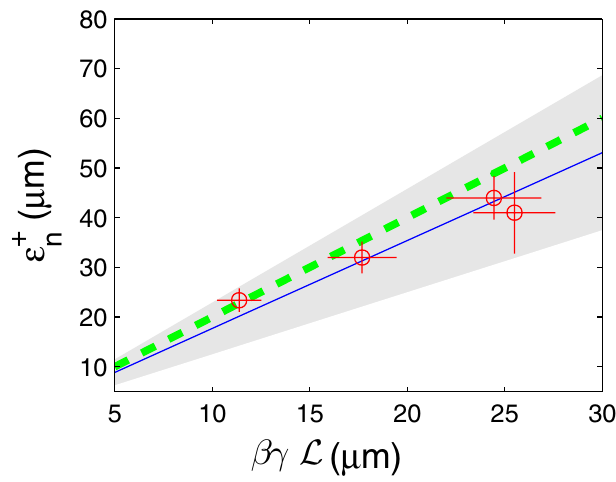
FIG. 7. (Color) Larger one of the flat-beam emittances ( " (cid:4) versus (cid:4)(cid:5) L . A linear regression (solid line) of the experimental data (circle) is compared with the theoretical dependence (dash line). The shaded area represents the 95% confidence bounds associated with the linear